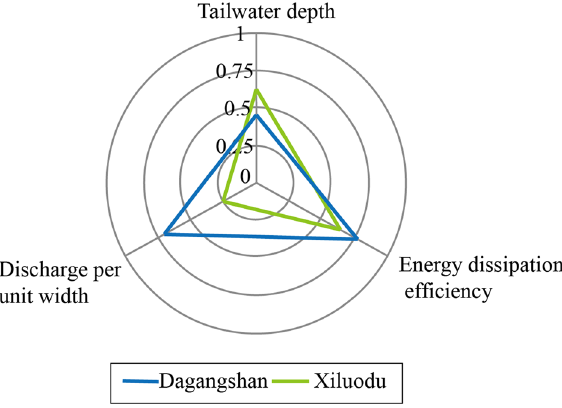
Figure 1. Correlation coefficient between TDG level and selected